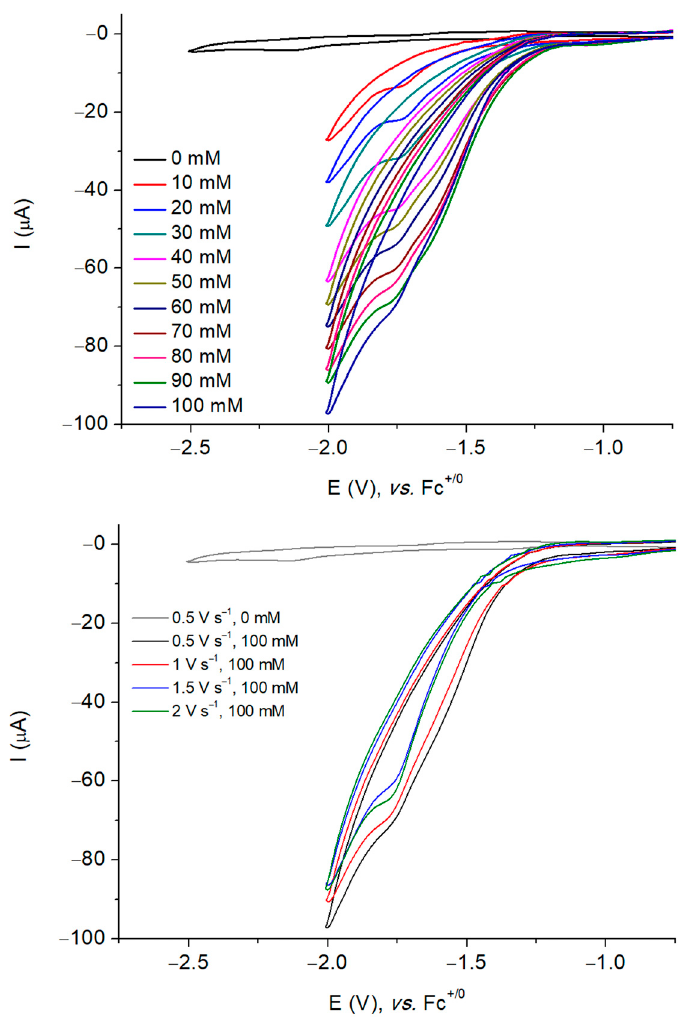
Figure 6. Successive cyclic voltammograms of a 1 mM solution of Ni 3 L 2 in DMF (0.1 M NBu 4 PF 6 ) recorded at a glassy carbon electrode with increasing amounts of TFA at 500 mV s − 1 ( top ) and with 100 mM TFA at five different scan rates ( bottom ). Potentials are referenced to the Fc +/0 electrode.